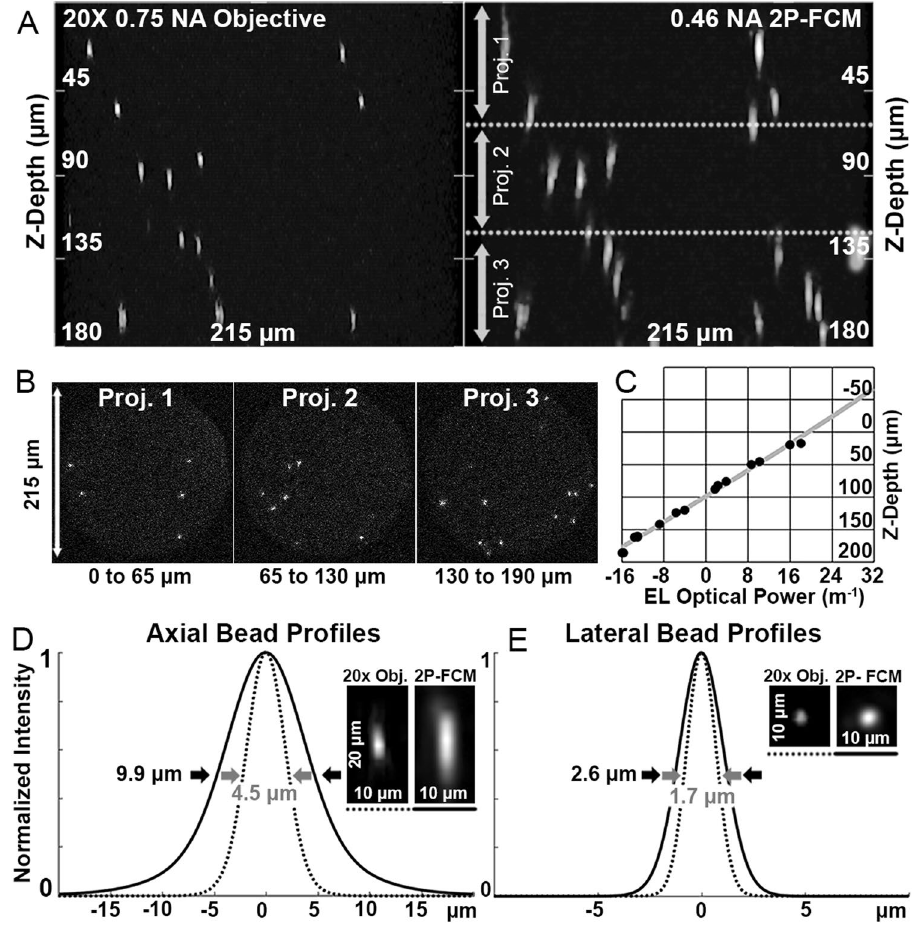
Figure 2. Resolution and testing of axial-scanning range. ( A ) Left: Side-projection of ~2 µ m diameter beads suspended in clear agarose and imaged with a 20x 0.75 NA Olympus objective using 910 nm excitation light. Axial focusing was accomplished by a motorized stage. Right: Same volume imaged with 2P-FCM at 910 nm. Axial focusing was accomplished by tuning the focus of the EWTL. ( B ) Sub-stack projections of 2P-FCM bead images from regions indicated in A (right panel). ( C ) Grey line is the predicted scan range as the EWTL optical power is changed, as modeled in Zemax. Black circles show measured positions of individual beads determined using a motorized stage. ( D ) Axial and lateral profiles of beads acquired with 2P-FCM (solid lines) and 20x objective with motorized stage (dashed lines). Profiles are Gaussian fits to averages of 5 beads. Insets show processed images of